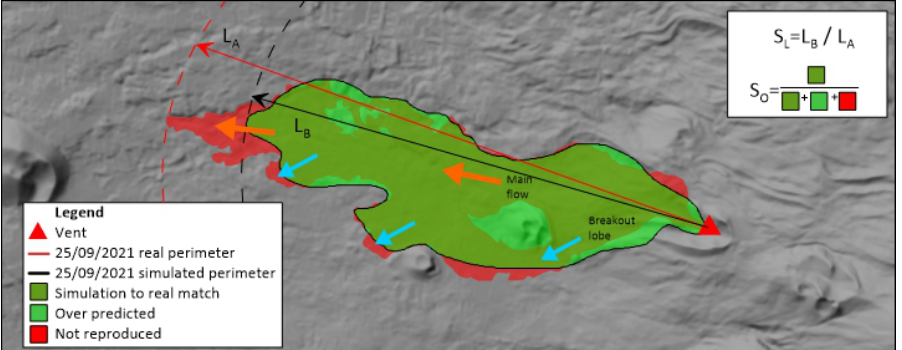
Figure 3. Abstract conceptual geometric definition of the elements (distances and areas) used in the maximum distance S L and Jaccard S O similarity indices between actual and simulated lava flows (background for decorative purposes, drawing not to